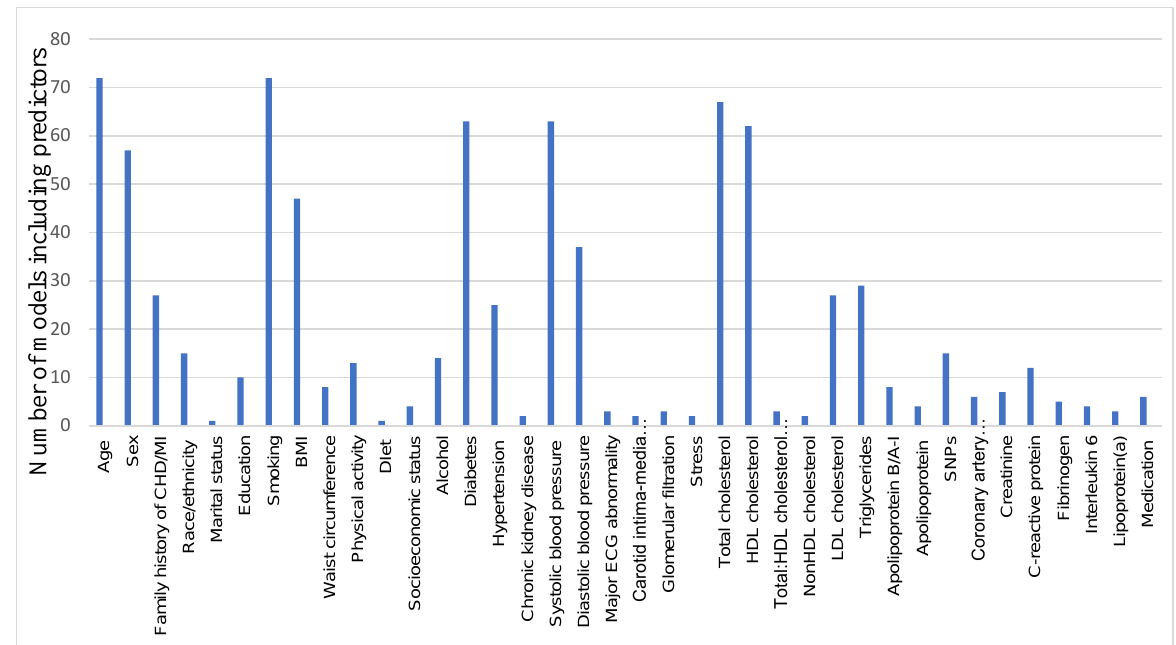
Figure 3. The main categories of predictors used in prediction models for CHD diseases. Several novel predictors were added to the Framingham model for predicting CHD events. Framingham predictors were used the most commonly (age, sex, smoking, SBP, TC, HDLC, and diabetes) compared to other predictors.